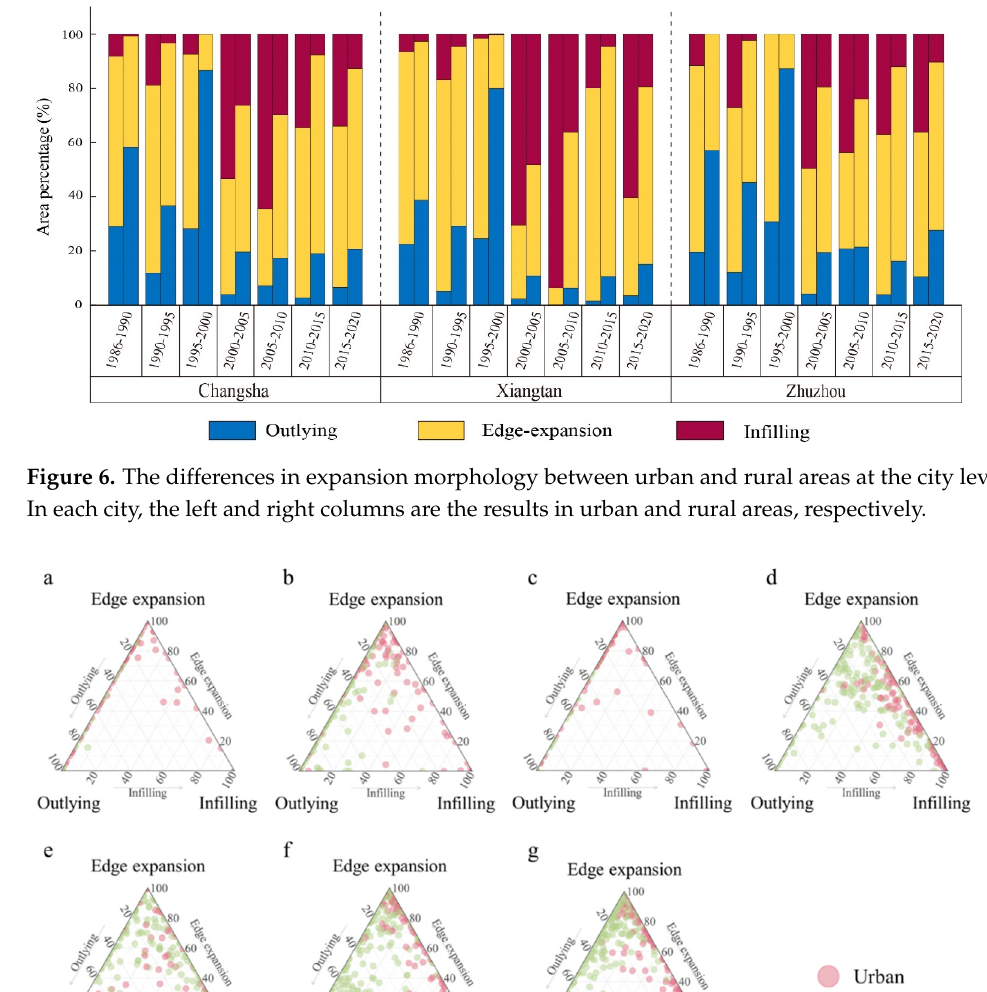
Figure 6. The differences in expansion morphology between urban and rural areas at the city level. In each city, the left and right columns are the results in urban and rural areas, respectively.